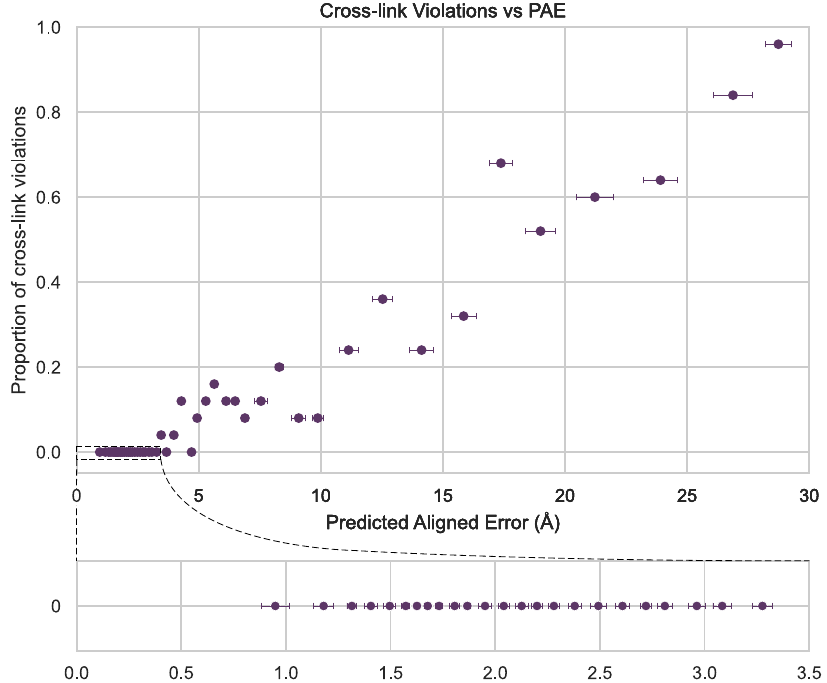
Fig. 5 The proportion of cross-link violations is well-predicted by AF2 ’ s Predicted Aligned Error score, suggesting that it accurately captures the accuracy of structural models. Considering the full set of cross-links in the 100 proteins, we ranked all cross-linked amino acid pairs by increasing PAE scores and divided them into 49 bins, comprising 25 cross-links per bin. For each bin of PAE values, we plotted the mean PAE score ( + / − 1 standard deviation) and the proportion of in situ cross-links violated within that bin (in the unrelaxed AF2-predicted structures). All relevant data are located in the Zenodo repository, accompanied by a Python notebook to compute raw and average